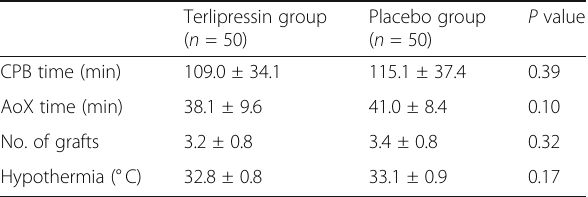
Table 2 Intraoperative